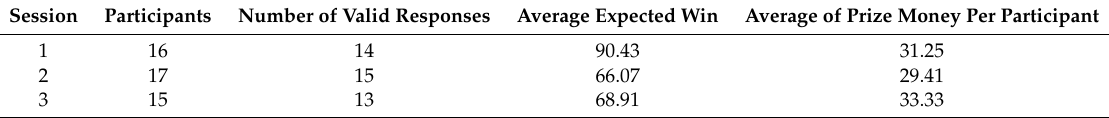
Table 3. Expected earnings for the three